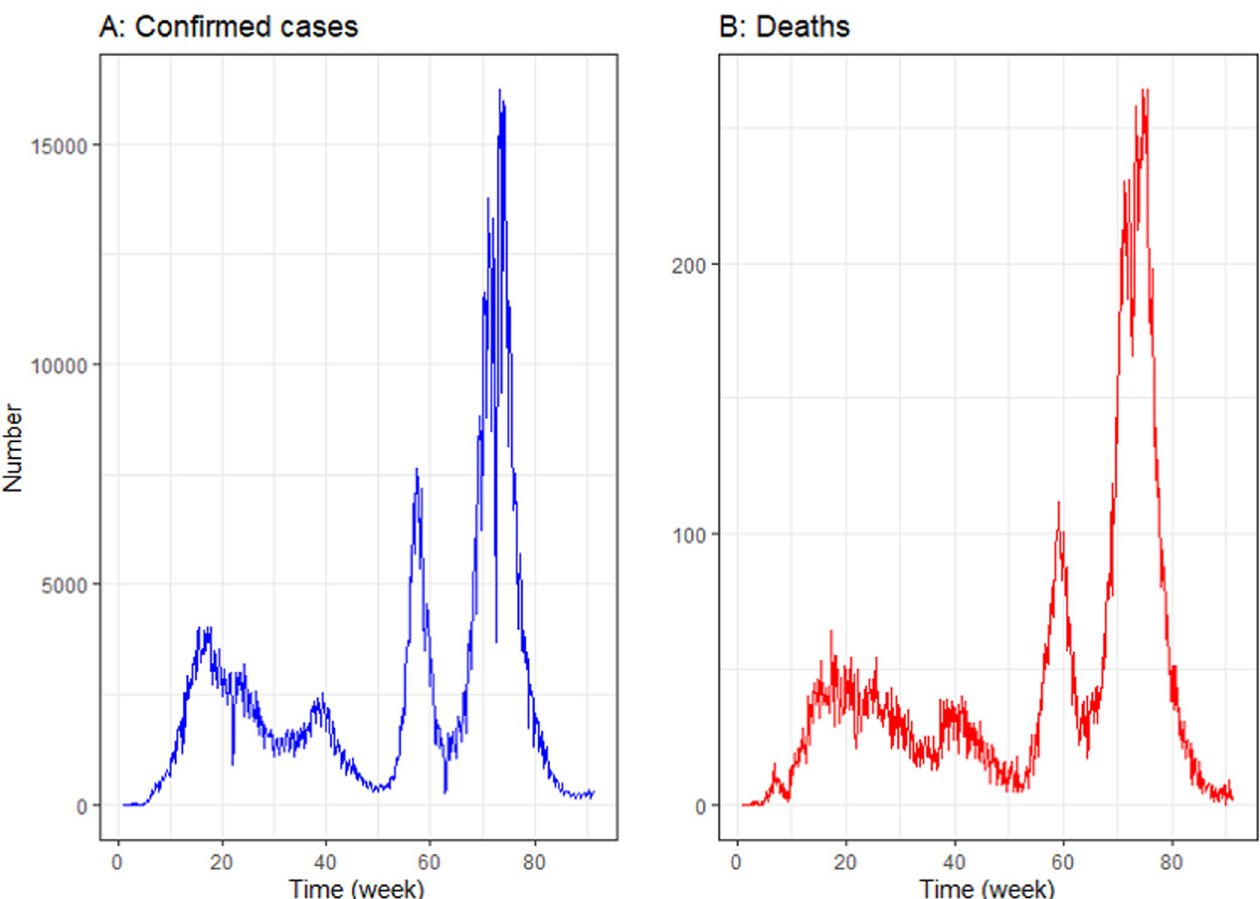
Fig 2. A 633 day (91 weeks) time series plot for confirmed COVID-19 cases and deaths in Bangladesh from March 08, 2020 to November 30,